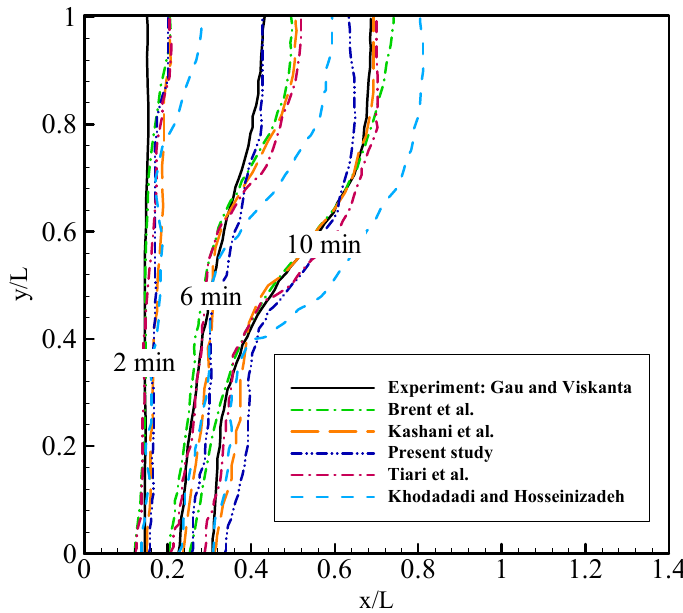
Figure 5. A comparison of melting interfaces, computed in the present study and the literature works [33–37] ; L is the enclosure’s characteristic length, L = 6.35 cm.